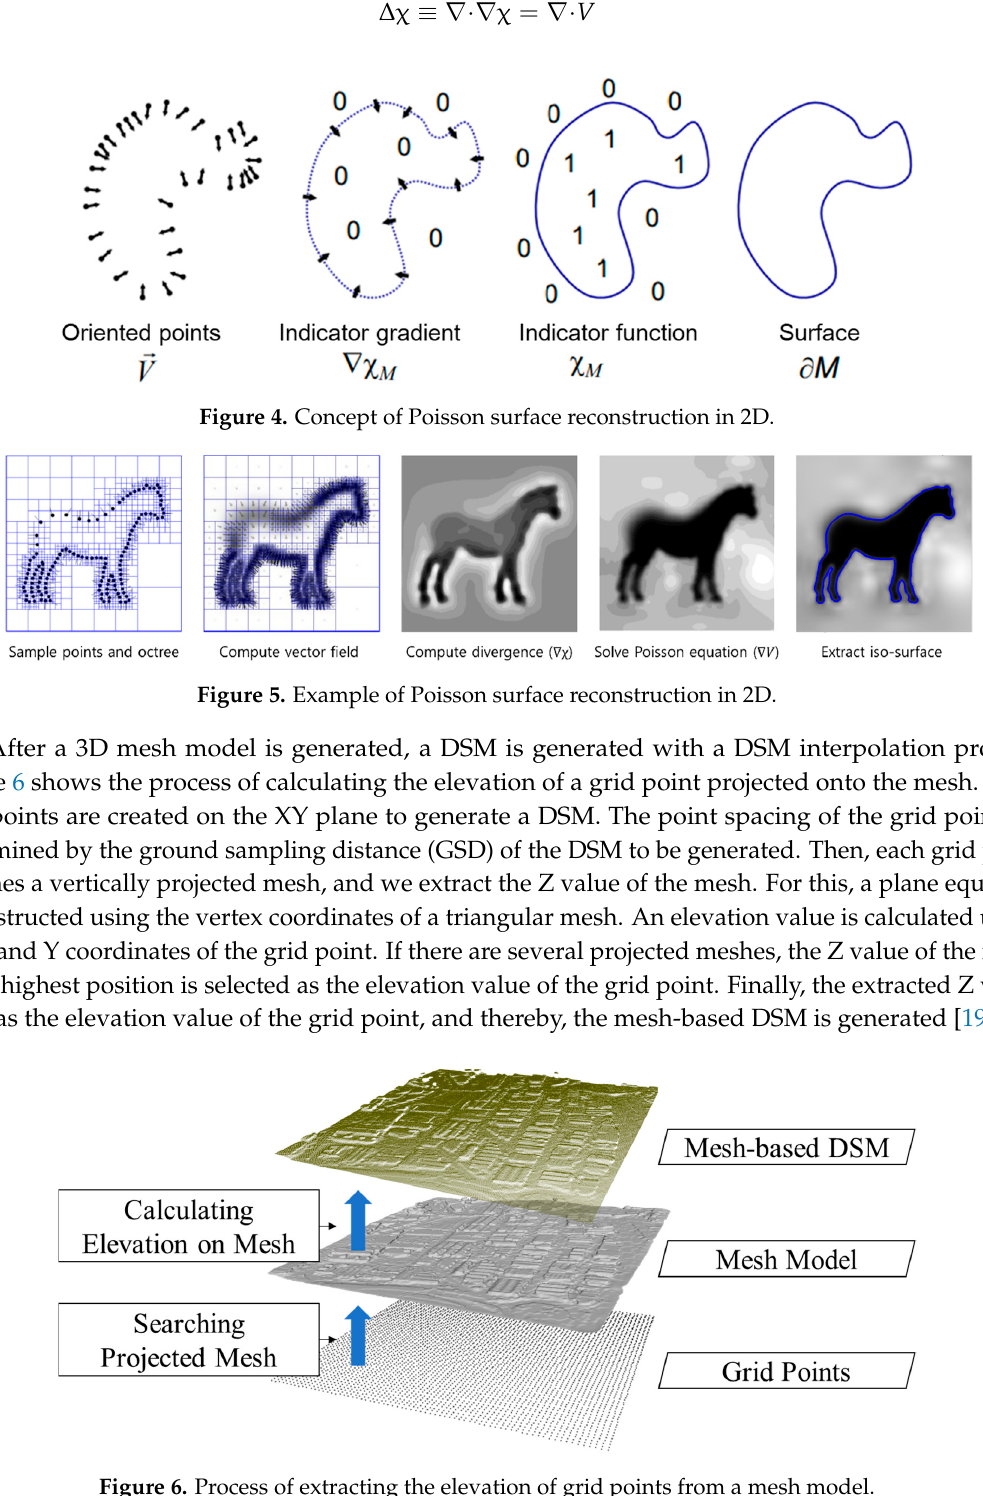
Figure 6. Process of extracting the elevation of grid points from a mesh model.